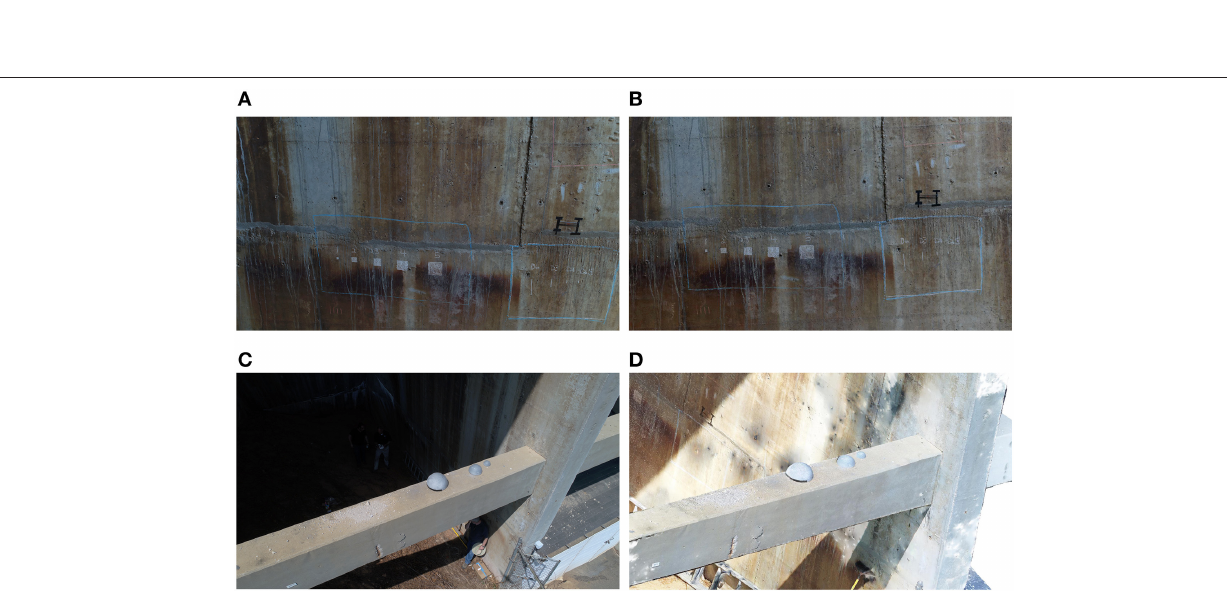
Frontiers in Built Environment |